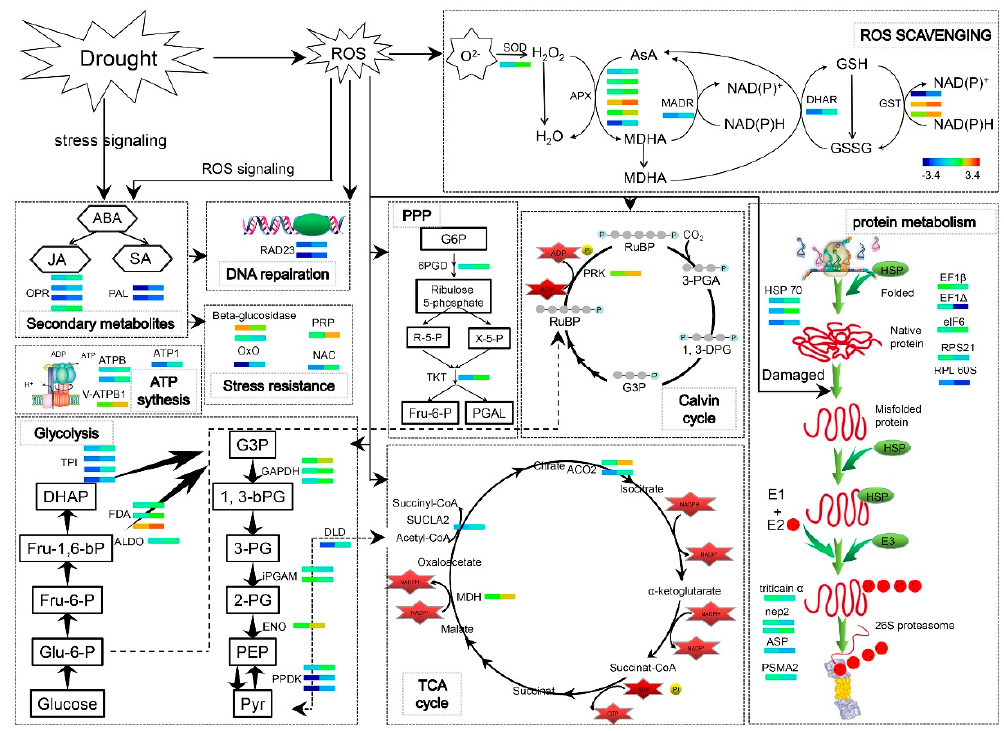
Figure 9. Diagram of the main metabolic pathways regulated by WV under drought stress. Each small colored square represents an individual protein under different treatments (from left to right, control and WV treated groups, respectively). Relative levels of expression are shown by a color gradient from low (blue) to high (red). SOD: Superoxide dismutase; APX: L-ascorbate peroxidase; MADR: Monodehydroascorbate reductase; DHAR: dehydroascorbate reductase; GST: glutathione transferase; OPR: 12-oxophytodienoate reductase; PAL: Phenylalanine ammonia-lyase; RAD23: DNA repair protein RAD23; ATPB: ATP synthase beta subunit; V-ATPB1: Vacuolar ATPase subunit B1;